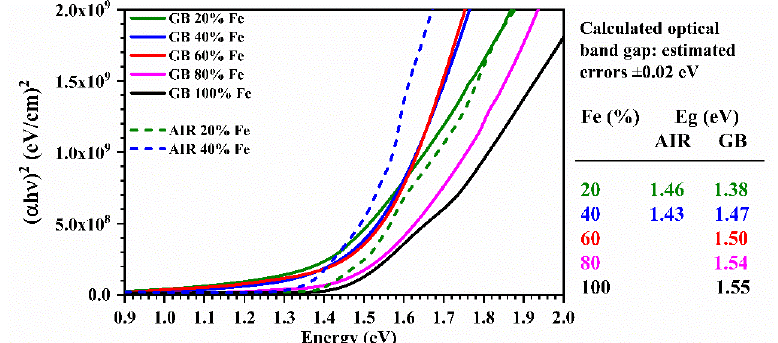
Figure 9. Plot of ( α h ν ) 2 as a function of h ν for the estimation of the optical bandgap of the 20% and 40% C(Z,F)TS thin films made in air; the 20%, 40%, 60%, 80%, and 100% C(Z,F)TS thin films made in glovebox; and the calculated optical band with estimated errors of ± 0.02 eV.